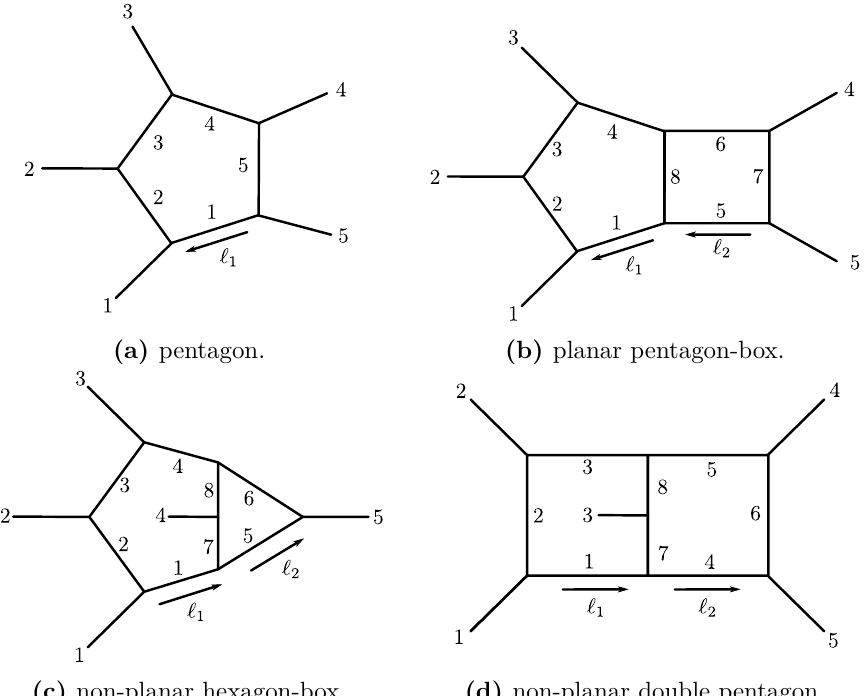
Figure 1. All integral topologies with the maximal number of denominators from each integral family considered in this work. Momenta and propagator indices are shown for the standard per- mutation σ 0 . All lines are massless, and all external momenta are incoming. The numbering of the denominators corresponds to equation